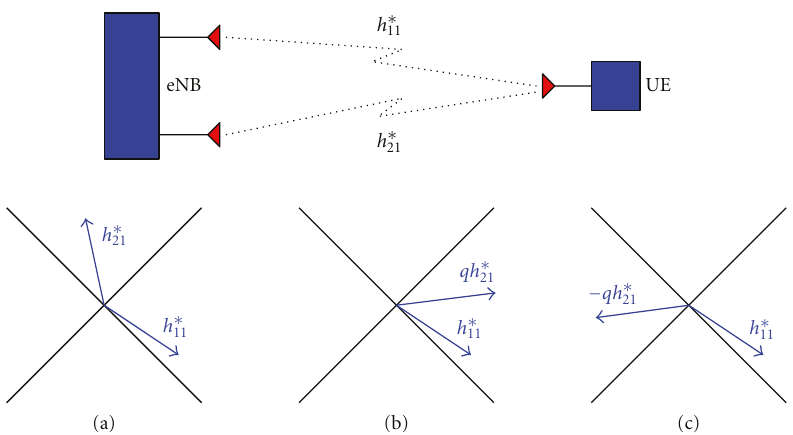
Figure 1: (a) shows the original channel from eNB to UE, while (b) shows the e ff ective channel of desired signal and (c) shows the e ff ective channel of interference of